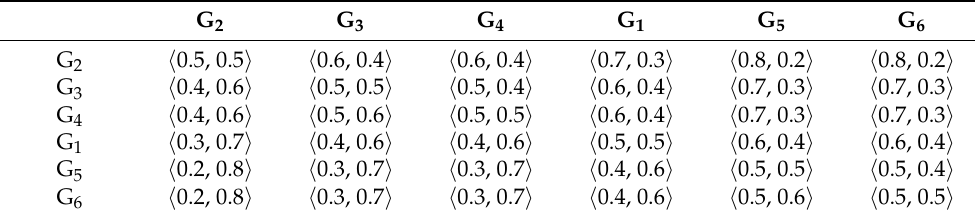
Table 4. Aggregated decision matrix in PF–AHP for the sub-criteria G ( CI = 0.0312977, CR = 0.0252401).